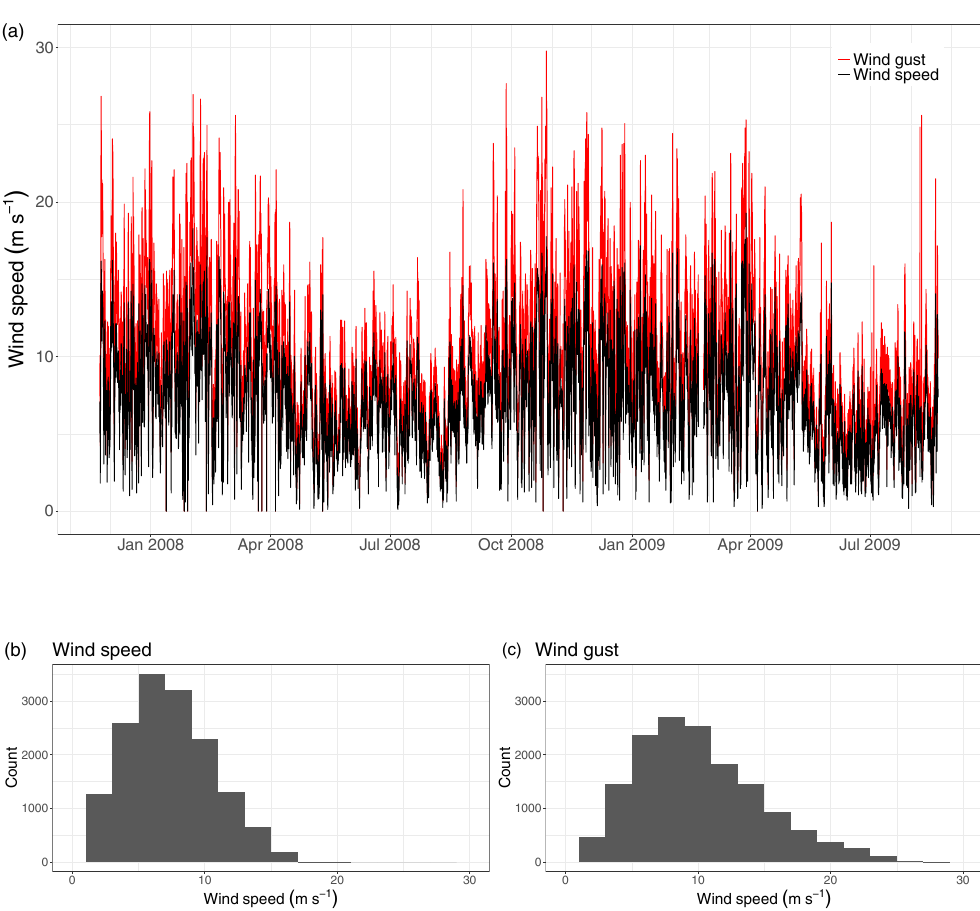
Figure 5. Measurements of wind speed and wind gust (ms − 1 ) at 4m height: time series (a) and histograms of wind speed measurements (b) and of wind gust measurements (c) .